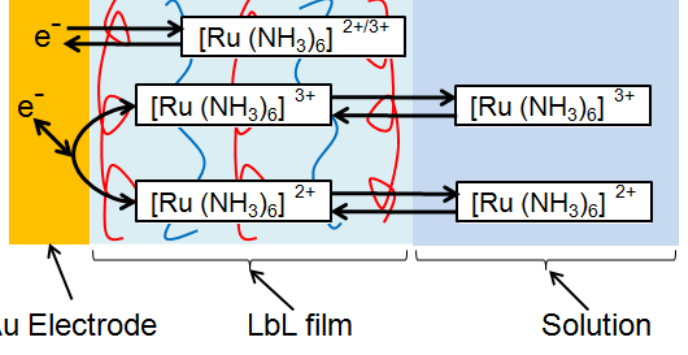
Figure 5. Schematic illustration of the redox reactions diffusing and confined Ru(NH ) 62+/3+ ions on the Au electrode. 3